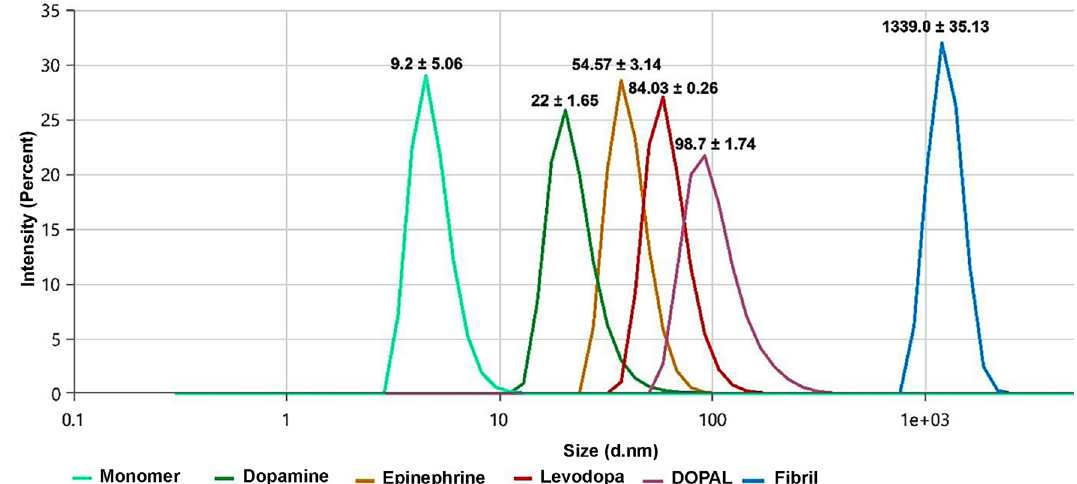
Figure 3. Size distribution of α-syn aggregates incubated alone (blue line) or with 200 µM dopamine (green line), epinephrine (yellow line), DOPAL (purple line), or levodopa (red line). Size distribution of monomer is also indicated (light green line). Results clearly indicate significant inhibition of α-syn assembly process mediated by catechols. All measurements were performed at pH 7.4 and room temperature (25 °C). Data are expressed as mean ± SD with n = 5.